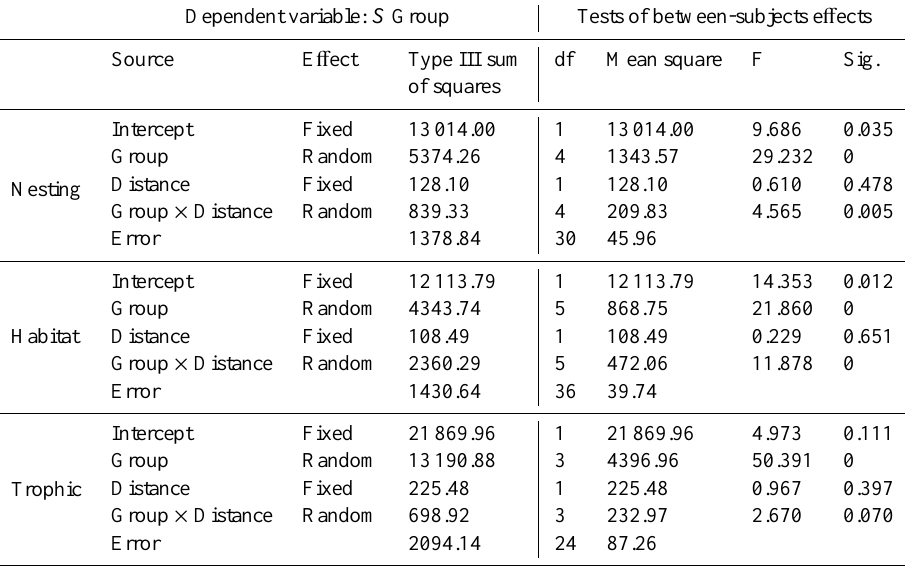
Table 7. General linear model analyses of the e ff ects of one fixed factor (distance) and one random factor (group) on the absolute abundance of the studied functional groups. The predictor “distance” represents eight increasing values estimated as the average distances from the city centre of each urbanization ring (UGR).